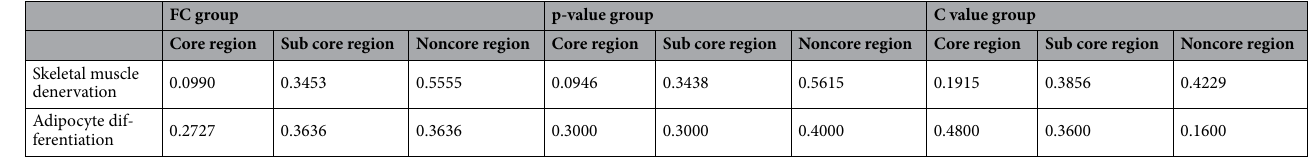
Table 5. The ratio of the number of genes in each group in different regions.